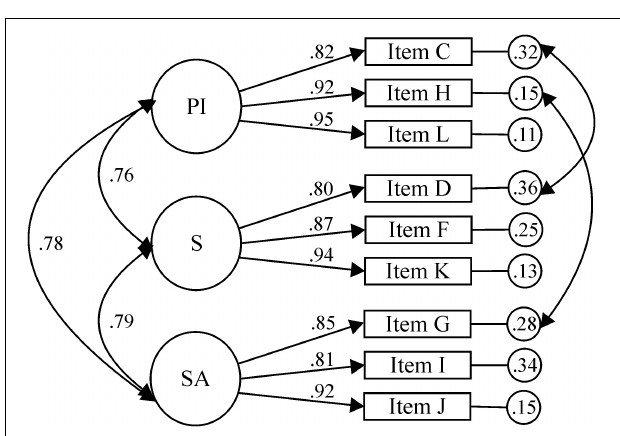
FIGURE 2 | Physical disability sub-scale.